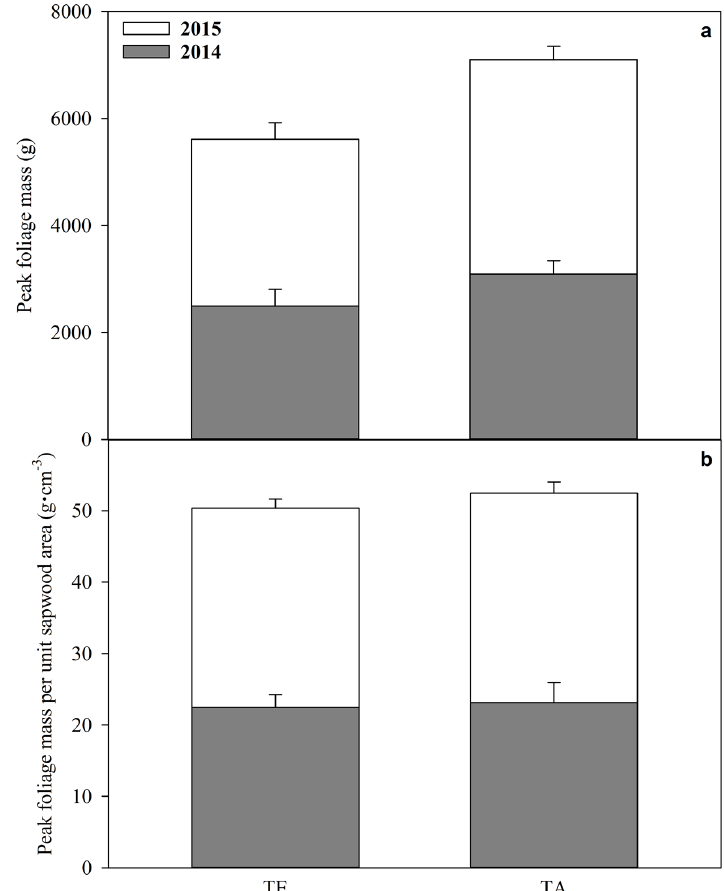
Figure 5. ( a ) Peak foliage mass and ( b ) peak foliage mass per unit sapwood area for the 2014 and 2015 foliage cohorts in response to 100% throughfall exclusion (TE) and ambient throughfall (TA) treatments. Error bars represent standard error of treatment means ( n = 5).